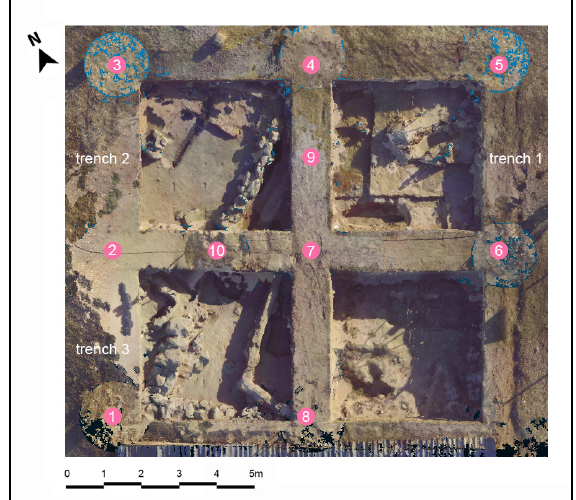
Figure 4 . Τhe positioning of the laser scanner during the first day of the fieldwork (10 measurements).